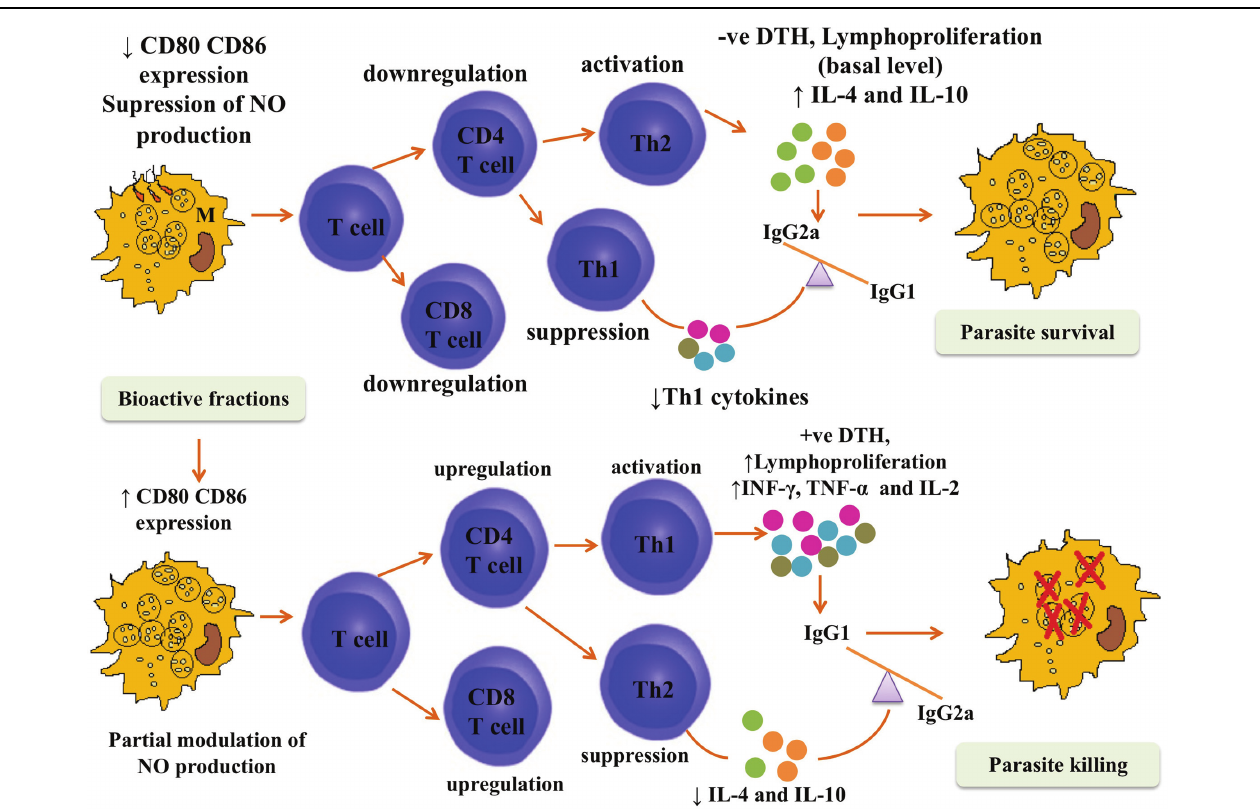
FIGURE 10 | Postulated mechanism for in vivo efficacy of P. nigrum bioactive fractions. The figure depicts that during the course of L. donovani infection in BALB/c mice, the immune response was tilted toward Th2 type. The co-stimulatory molecules CD80 and CD86 were downmodulated and NO production was suppressed. CD4 + and CD8 + T cell numbers also declined and the immune response was driven toward Th2 type under the influence of elevated IL-4 and IL-10 levels leading to parasite survival characterized by negative DTH and only basal levels of lymphoproliferation. This immune containment was reversed following treatment with P. nigrum bioactive fractions. The CD80–CD86 expression was elevated, NO was enhanced, and splenic CD4 + and CD8 + T numbers were also augmented. Enhanced secretion of proinflammatory cytokines (INF- γ , TNF- α , and IL-2) further strengthened the Th1 potentiation as was evident from positive DTH and strong lymphoproliferative response and led to parasite killing.